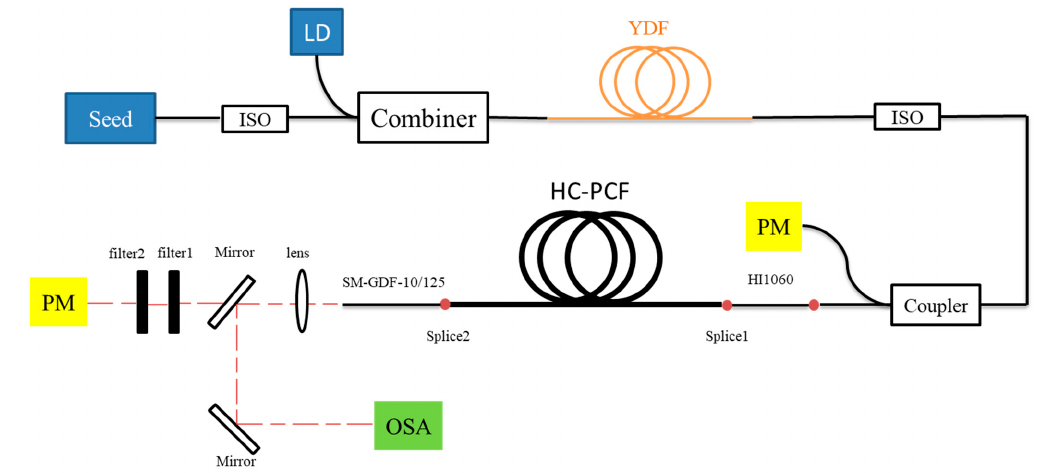
Figure 1. Experimental setup: ISO, optical isolator, LD, laser dioxide, PM, power meter, OSA, optical spectrum analyzer.